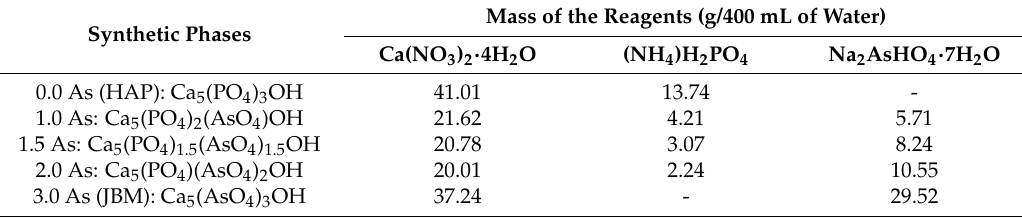
Table 1. The reagents used in the